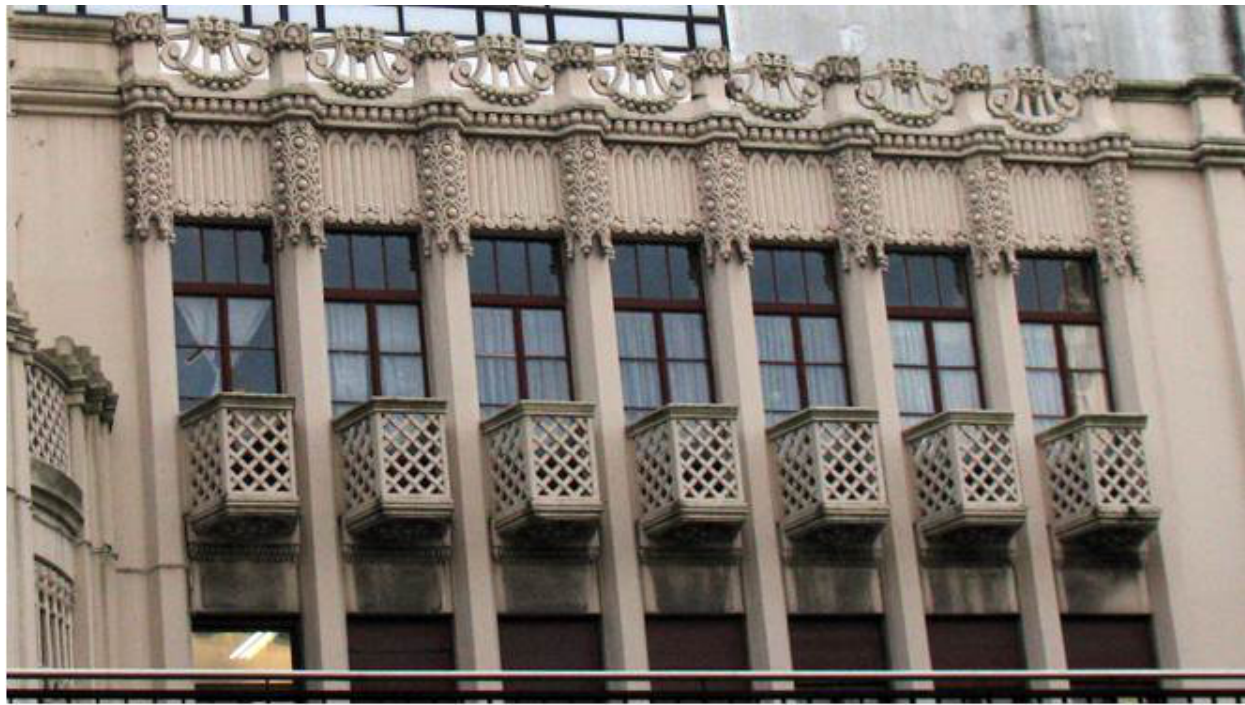
Figure 6. Heterogeneous development of coatings related to architectural characteristics with clear predominance in sheltered